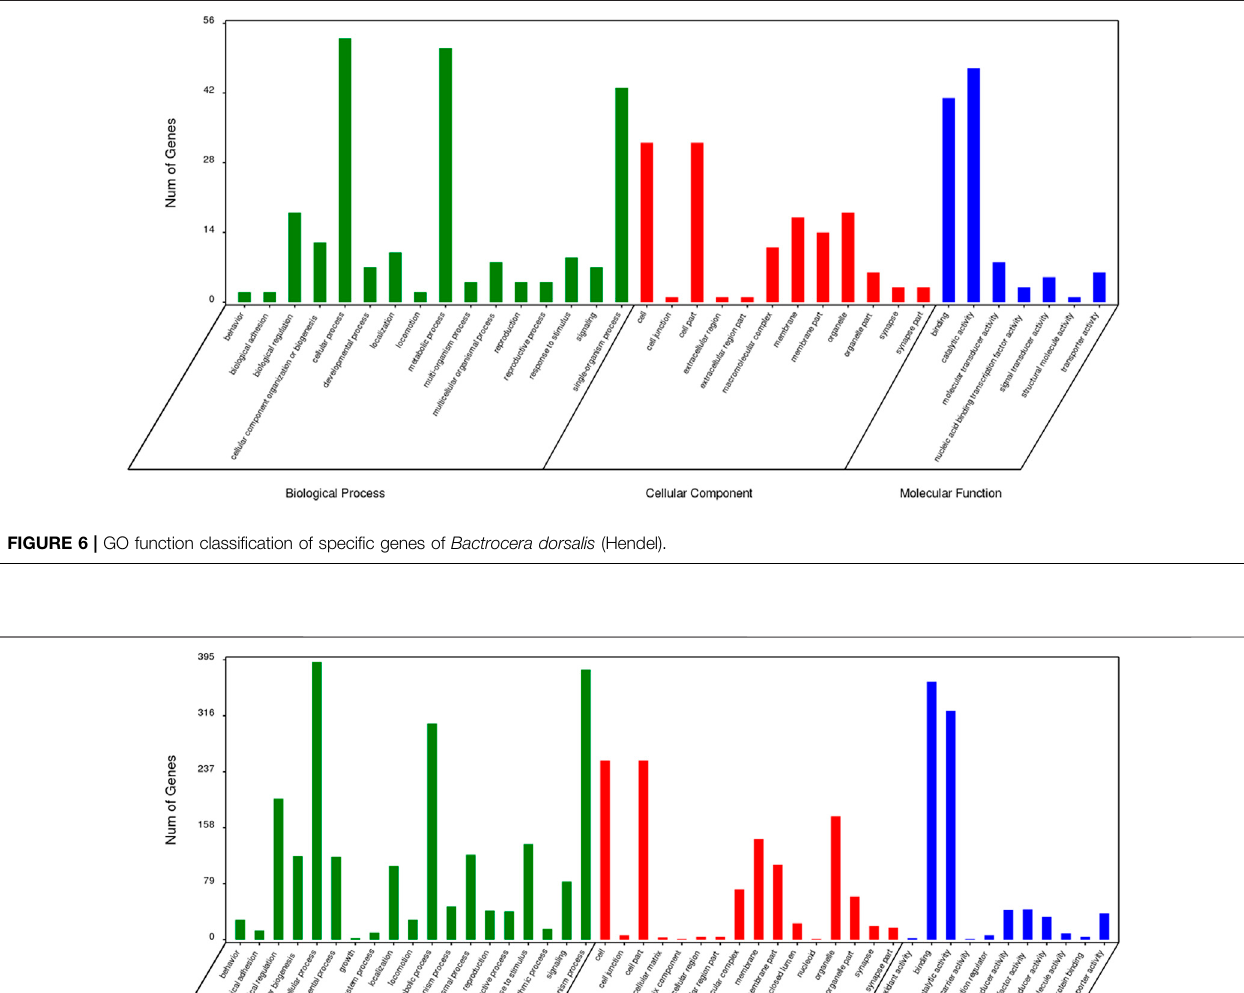
Frontiers in Genetics |